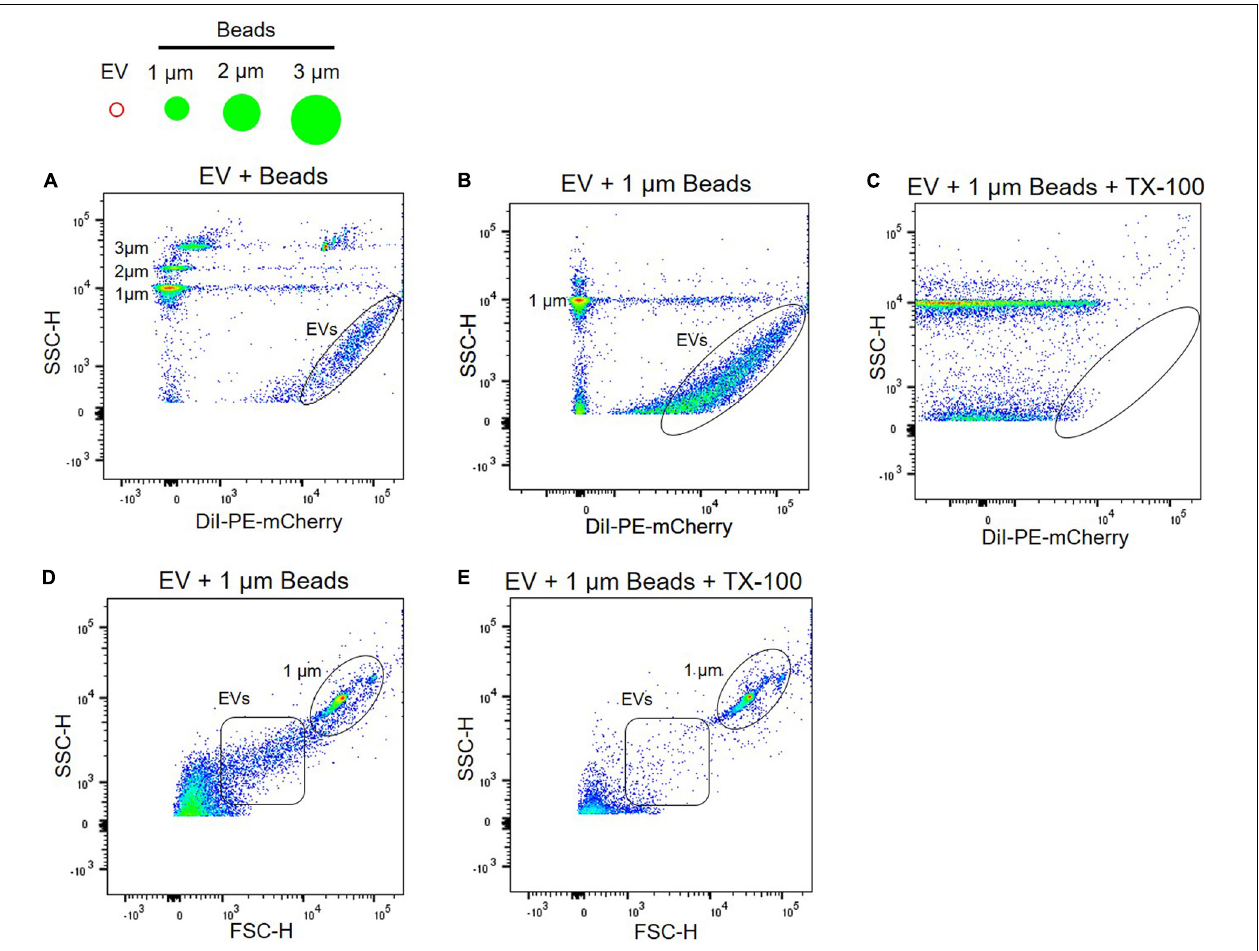
FIGURE 3 | Characterization of EVs using flow cytometry. (A) Plasma EVs labeled with DiI were compared with different sizes of beads, i.e., 1, 2, and 3 µ m. Light scatter signals correspond to the size of beads, and DiI labeling of EV samples (black circle) increases fluorescence signal. Plasma EVs labeled with DiI (black circle) were mixed with 1 µ m beads in the absence (B) and presence (C) of 0.1% Triton X-100. Light scatter and fluorescence signals of DiI-labeled EVs were absent after detergent lysis. Dot plot of forward scatter (FSC) signal for plasma EVs (black square) and 1 µ m beads (black circle) in the absence (D) and presence (E) of 0.1% Triton